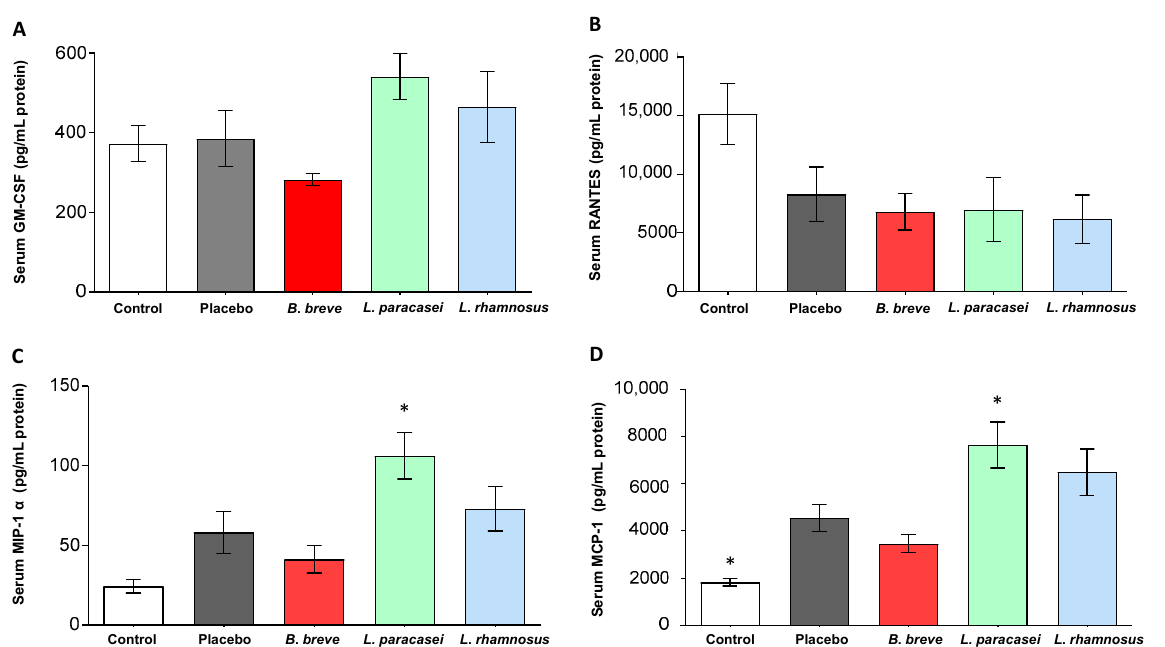
Figure 1. Serum concentration of ( A ) GM-CSF, ( B ) RANTES, ( C ) MIP-1 α , and ( D ) MCP-1 of rats fed either placebo, B. breve CNCM I-4035, L. paracasei CNCM I-4034 or L. rhamnosus CNCM I-4036 for 30 days. Values are the means ± SEM. n = 8 per group. * p < 0.05 vs. placebo. B, Bifidobacterium ; GM-CSF, granulocyte-macrophage colony-stimulating factor; L, Lactobacillus ; MCP-1, monocyte chemoattractant protein-1; MIP-1 α , macrophage inflammatory protein 1-alpha;RANTES, Regulated upon Activation, Normal T Cell Expressed and Presumably Secreted.